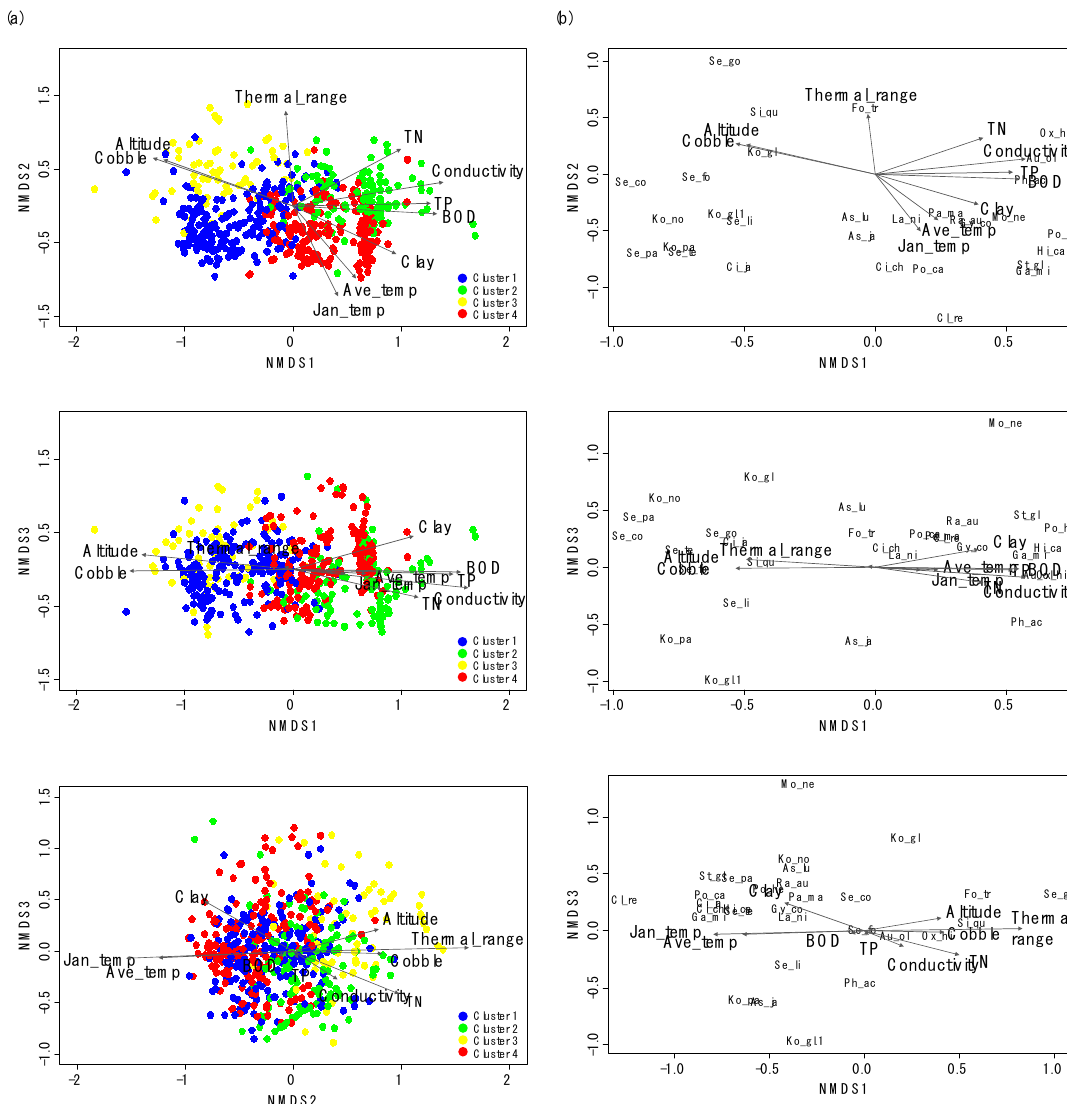
Figure 3. Nonmetric multidimensional scaling (NMDS) ordination of sampling sites ( a ) with gastropod assemblages ( b ). The first three axes (Kruskal’s stress = 13.8) were used to visualize the ordination. Arrows correspond to environmental variables significantly related to assemblage composition (only environmental variables with R 2 > 0.2 are presented). Arrow length is proportional to the correlation magnitude ( r ). The abbreviations for the environmental variables and species names are explained in Tables 1 and 2, respectively.